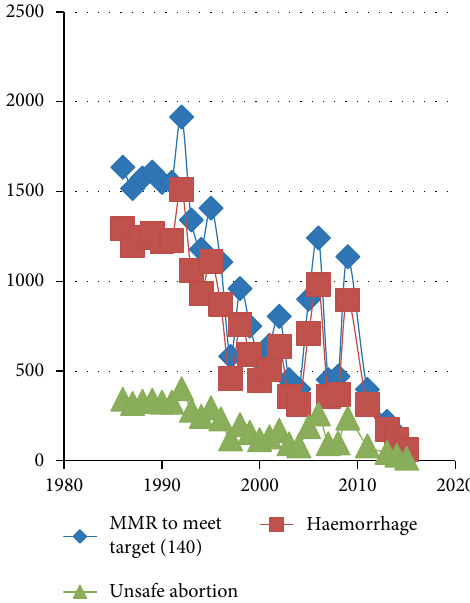
Figure 4: MMR due to physiological causes and unsafe abortion (1986–2015). Two significant physiological causes, haemorrhage and unsafe abortion, are shown in Figure 4 from 1986 to 2015. While MMR is reducing reasonably well, the reduction in unsafe abortion is much slower than the reduction in haemorrhage.